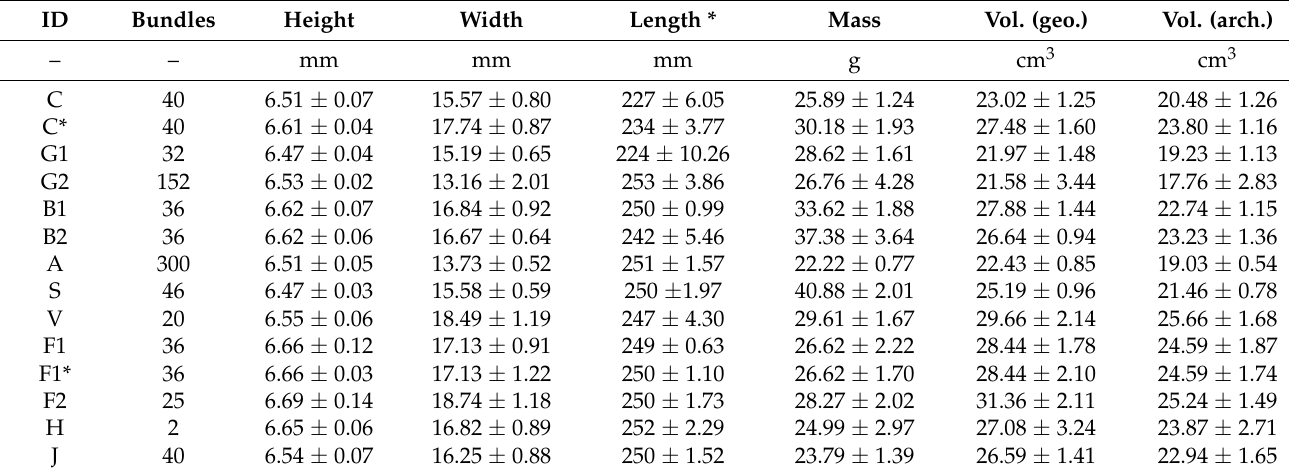
Table 4. Parameters of the produced four-point bending